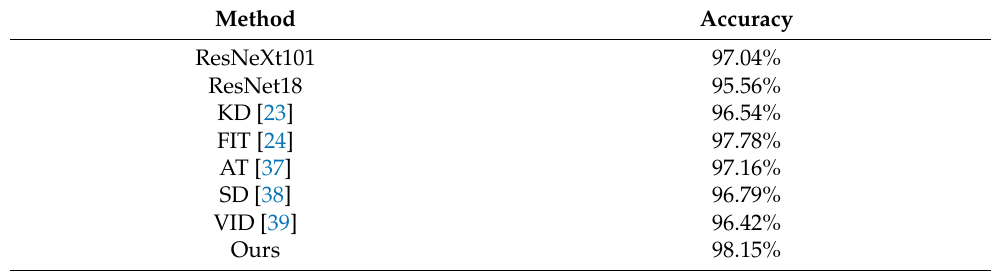
Figure 4. Confusion matrix for classification at different stages. Table 5. Comparison of accuracy between the proposed and existing knowledge-distillation methods on